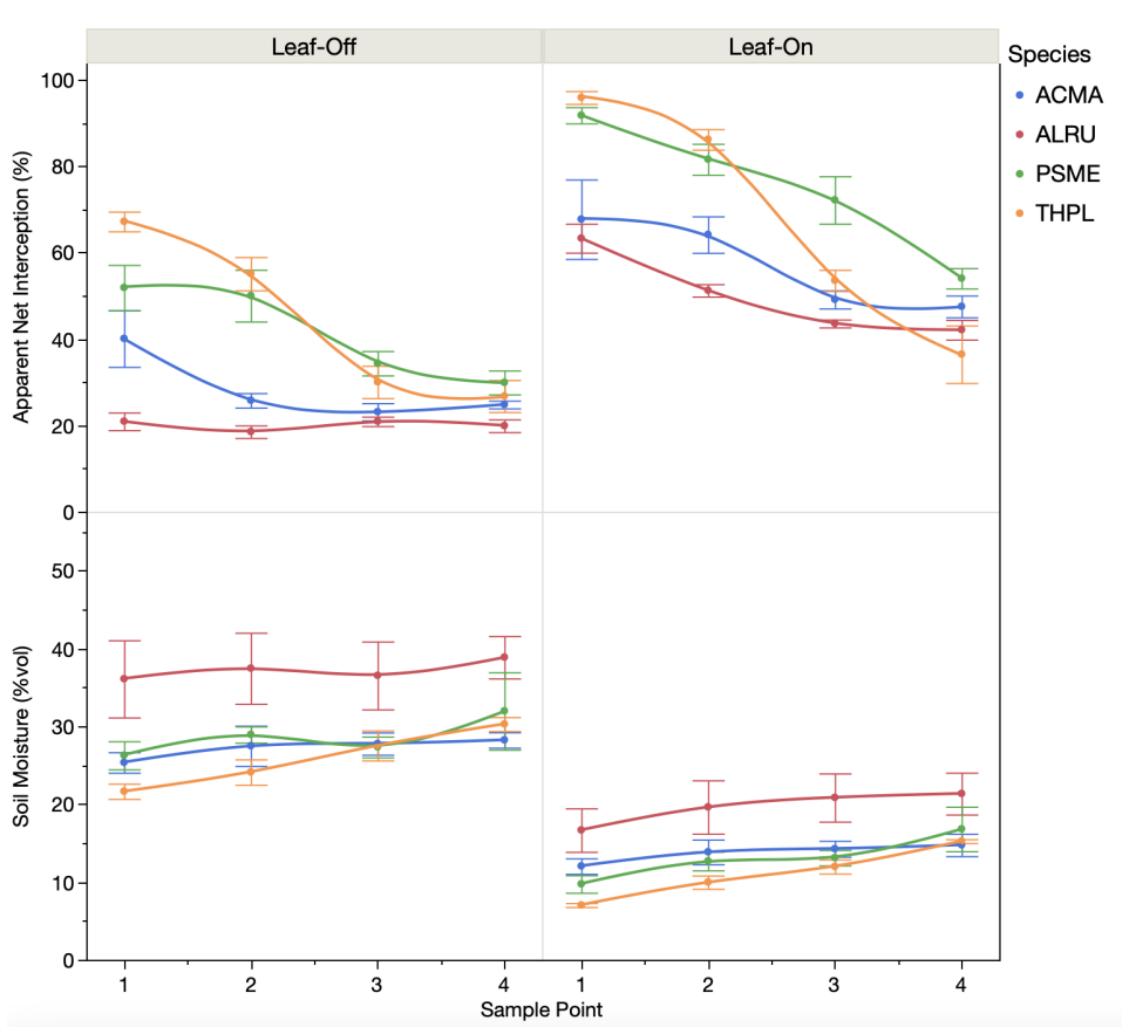
Figure 2 . Catchment interception and adjacent soil moisture in relation to distance from trees. Relationships represent cubic spline regression fits the data. Top panels: relationships between catchment sample point and estimated canopy interception of throughfall under four species of tree in leaf-off and leaf-on periods. Bottom panels: relationship between soil moisture and sample points. For all points, catchment and soil moisture values represented are averaged by species and collection period. Species codons in the legend refer to A. macrophyllum (ACMA), A. rubra (ALRU), P. menziesii (PSME), and T. plicata